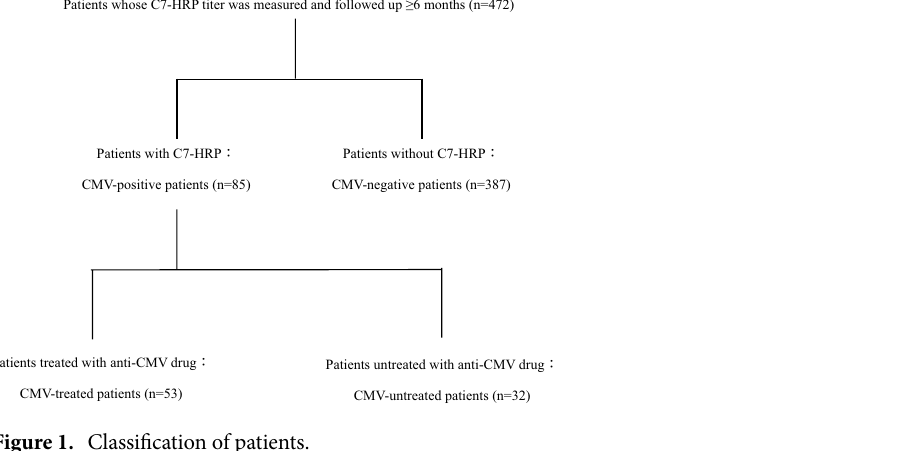
Figure 1. Classification of